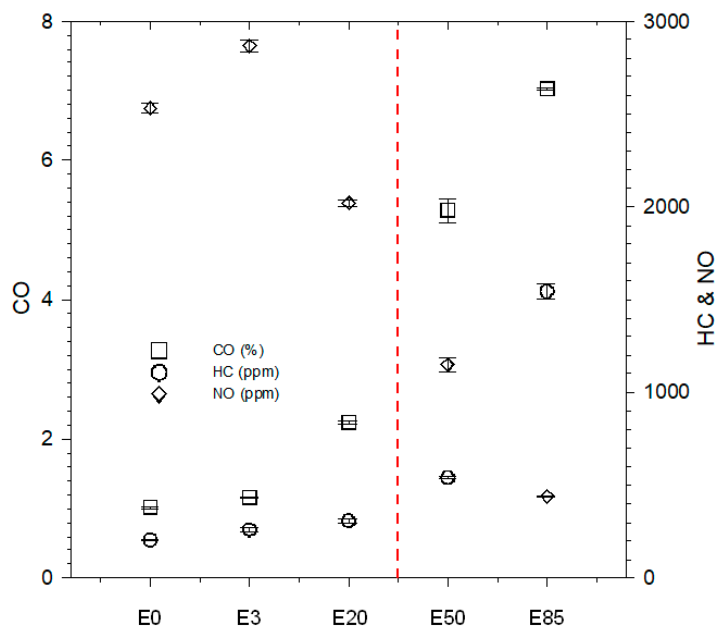
Figure 10. Emissions of CO, HC, and NO for ethanol/gasoline blended fuel.